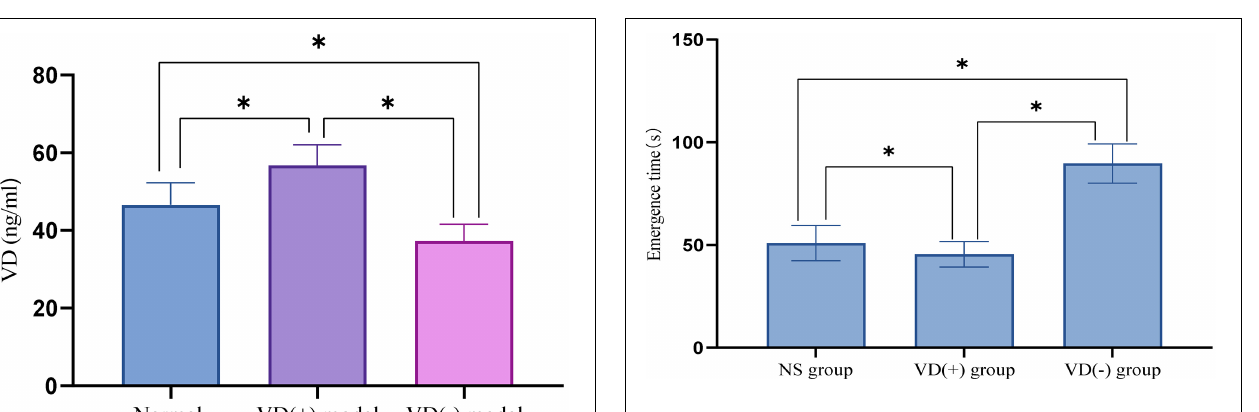
FIGURE 2 | Comparison of emergence time among the anesthesia treatment group, ∗ P <